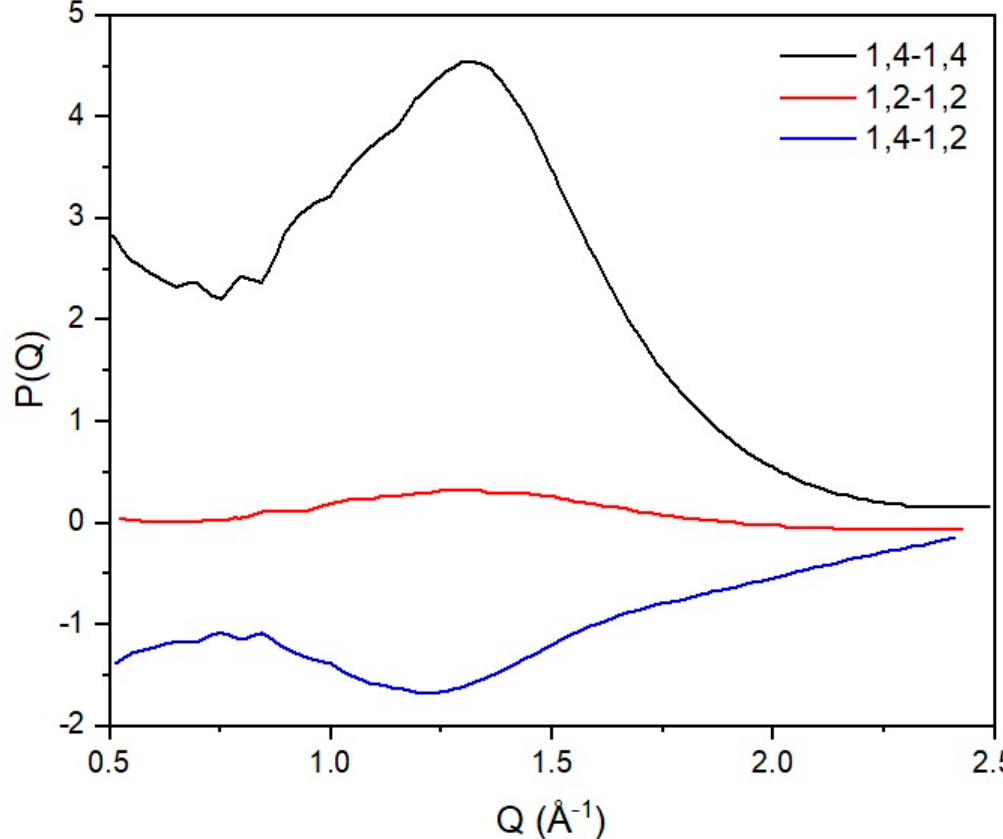
Figure 5. Partial structure factors for the different correlations derived from experimental data on blends of 1,2 and 1,4 polybutadiene. 1,2-1,2 (red), 1,2-1,4 (blue) and 1,4-1,4 (black) indicate the correlations between segments of 1,2 and 1,4 polybutadiene respectively. See text for more detailed discussion.